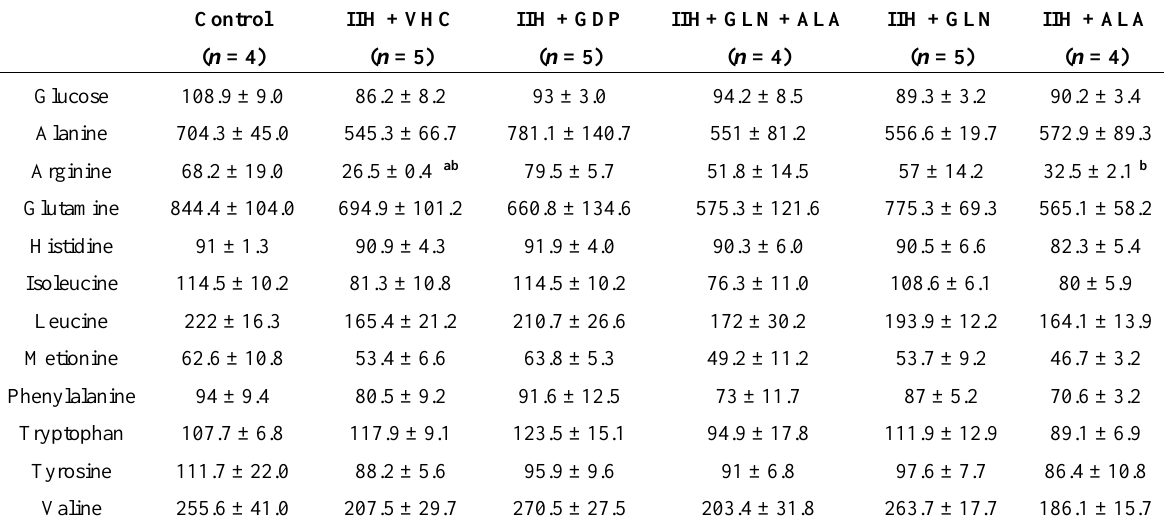
Table 1. Blood glucose (mg/dL) and amino acid (nmol/mL) levels 15 min after intraperitoneal insulin injection (IIH group). The IIH group was divided into 5 subgroups: IIH + oral vehicle (VHC), IIH + oral glutamine dipeptide (GDP), IIH + oral glutamine (GLN) + oral alanine (ALA), IIH + oral GLN or IIH + oral ALA. GDP (100 mg/kg )